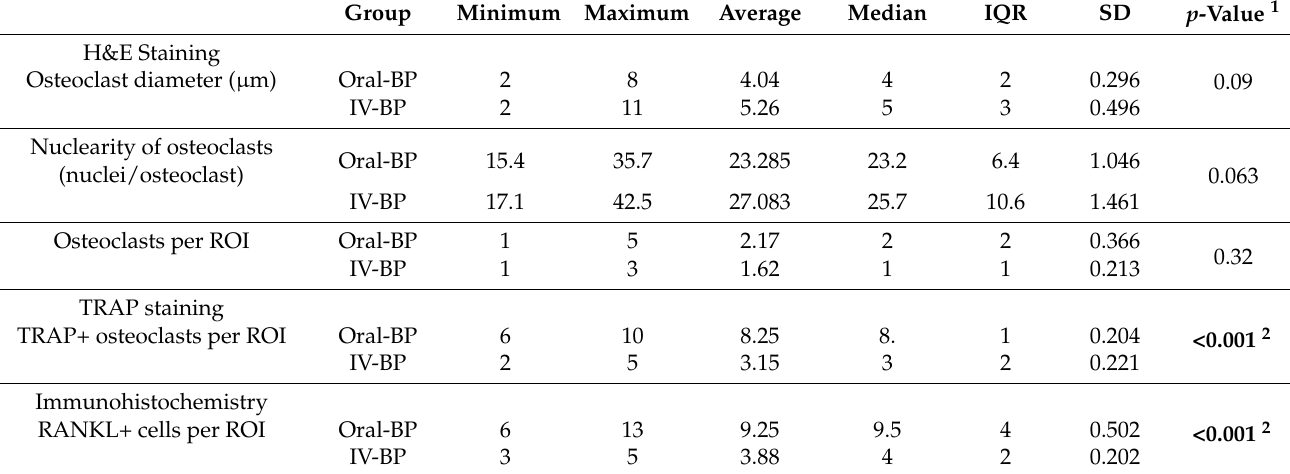
Table 2. H&E, TRAP, and IHC analysis of the specimens retrieved from the Oral-BP, IV-BP groups.